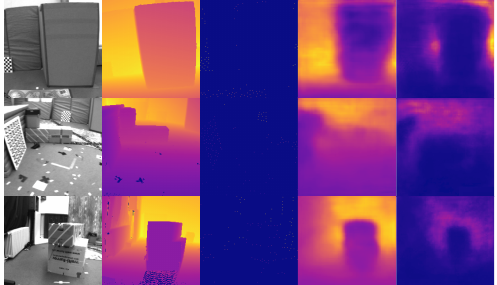
Figure 9. Cross-domain performance. Dense depth and depth uncertainty prediction results on EuRoC dataset in Gray + Sparse Depth modality of the network only trained on NYU Depth V2 dataset. From left to right column: input gray images, dense depth ground truth, sampled sparse FAST corners, and predictions of dense depth and depth uncertainty maps.